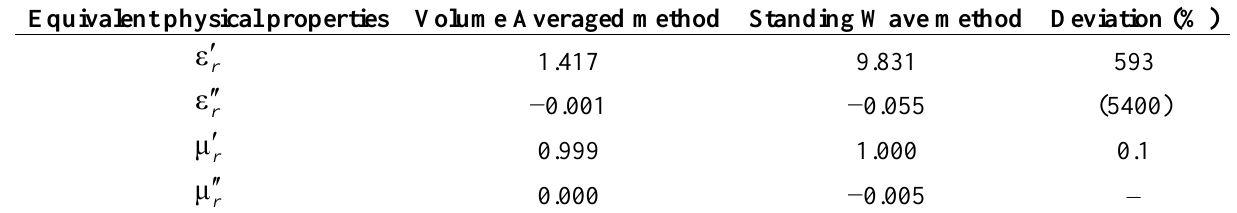
Table 6. Equivalent physical properties of particle-shaped aluminum (volume rate: 10%).